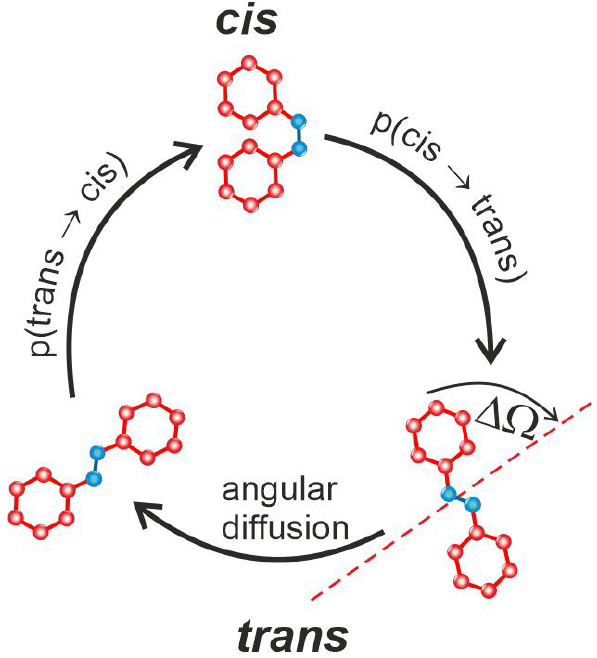
Figure 5. Scheme of trans-cis-trans cycle and angular diffusion process. Based on